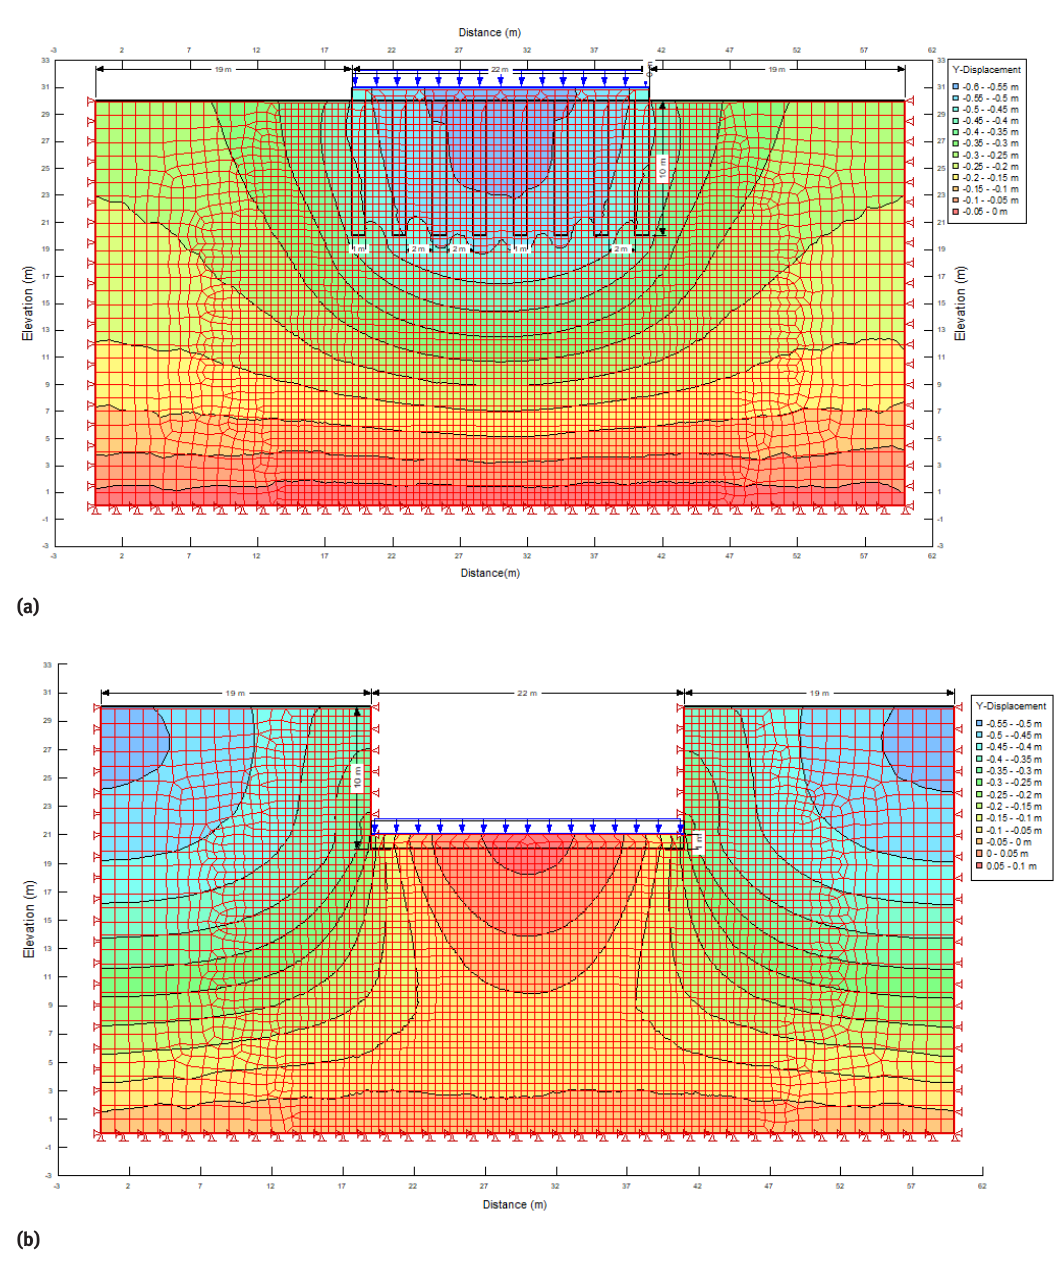
Figure 2: Vertical settlements evaluated for scenarios 1 (a) and 2